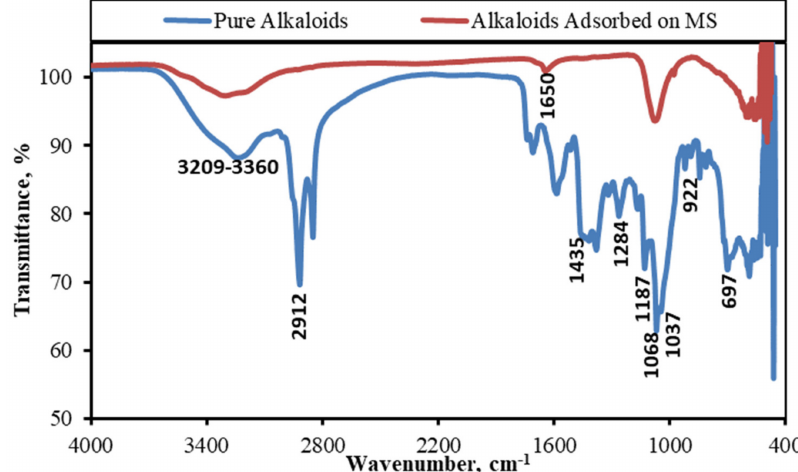
Figure 2. FT-IR spectrum of a pure alkaloid and the alkaloids adsorbed on the MS surface.